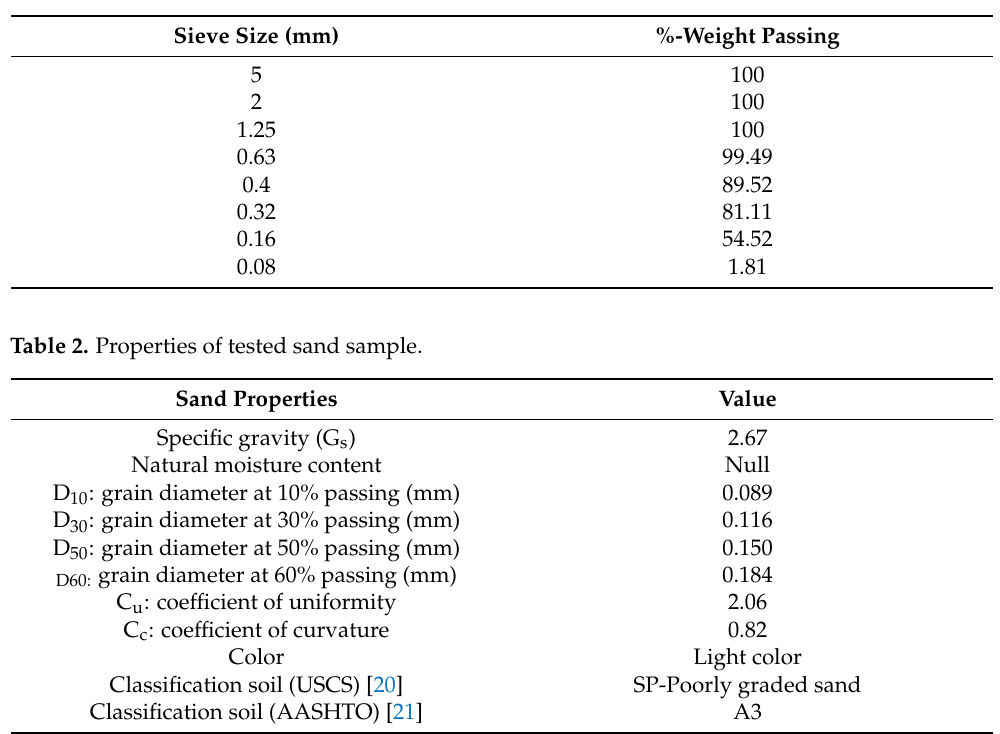
Table 1. Cumulative %-weight passing after sieving analysis [19].